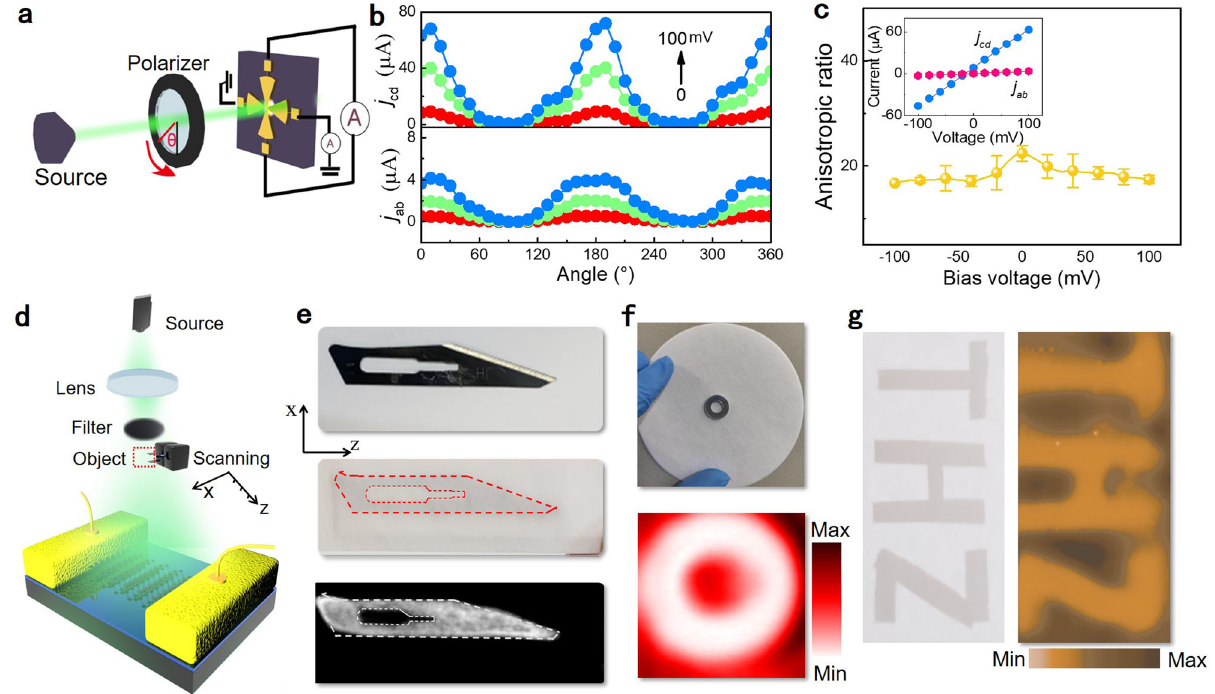
Fig. 4 High-frequency anisotropy photocurrent and imaging application. a Schematic illustration of the polarization-sensitive photocurrent measurement. b Polarization-angle dependence of the photocurrent response along the x, y direction at different bias voltages. The angle of the polarizer rotates clockwise with respect to the polarization orientation of the incident light. The anisotropic ratio is de fi ned as the ratio of the photocurrent response in the y direction to that in the x direction. c Different photocurrent corresponding to two mutual vertical electrodes increase with the bias voltage. Anisotropic photocurrent response of device along two orthogonal crystalline directions with bias added up to ±100 mV. d Optical path diagram based on THz imaging. e – g Photographs of the enclosed blade, copper lettering “ THz ” and metallic ring, and their raster scanning imaging at 0.3 THz. The objects were clearly revealed in an envelope, which was invisible to the naked eye. The NiTe 2 -based detector was biased at 10 mV during imaging